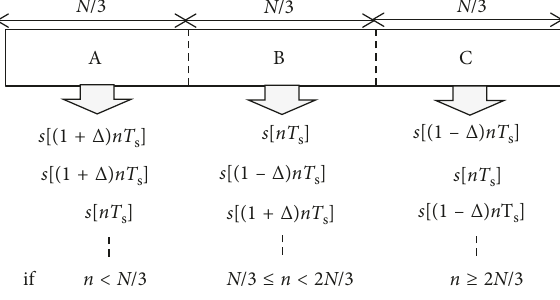
Figure 6: OFDM block with Doppler shift patterns.